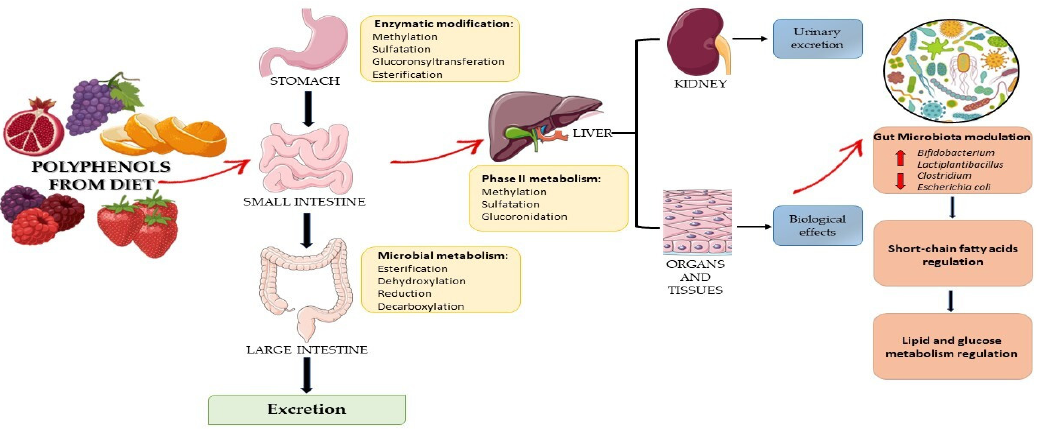
Figure 3. Effects of dietary polyphenols on gut microbiota, their metabolites, and health benefits.